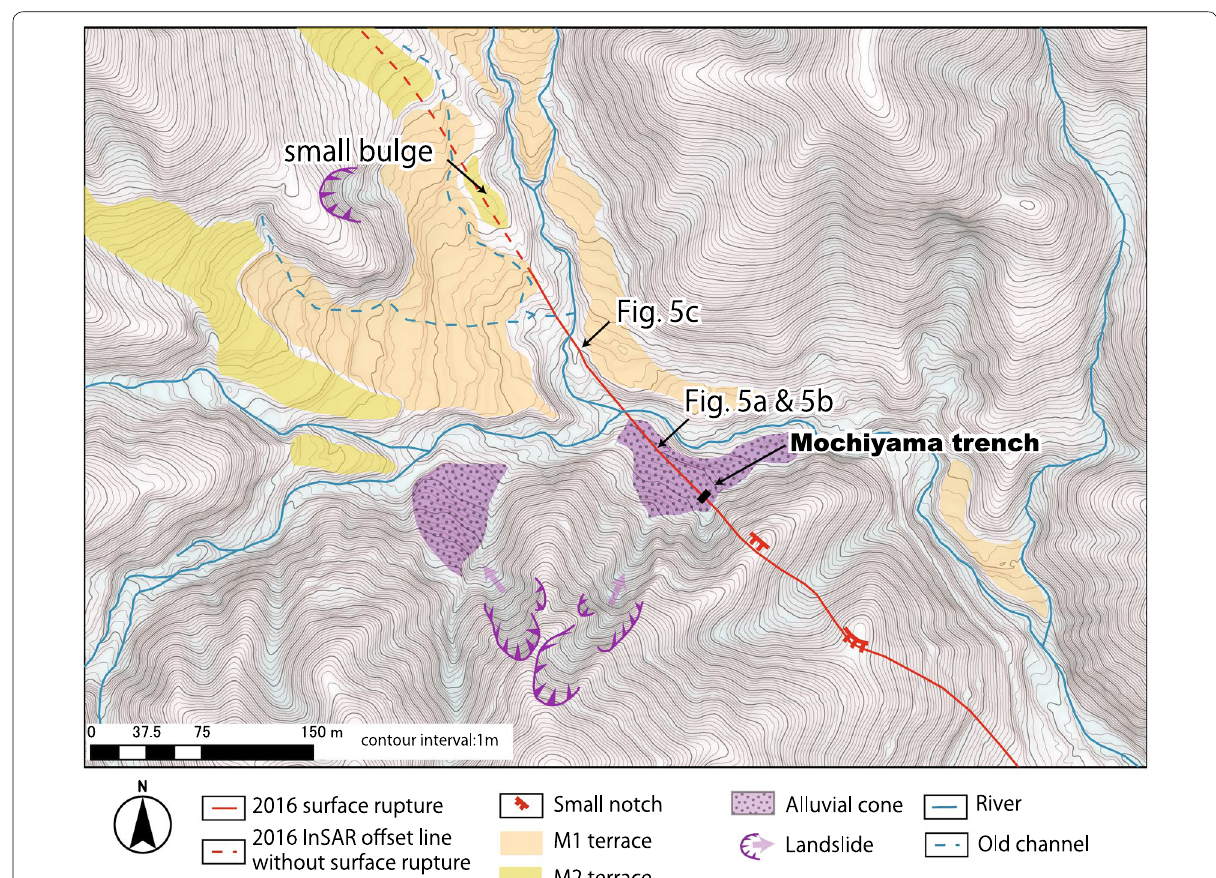
Fig. 6 Geomorphic map near Mochiyama showing the location of the trench excavation. Base map and contours are based on a lidar DEM with 2-m